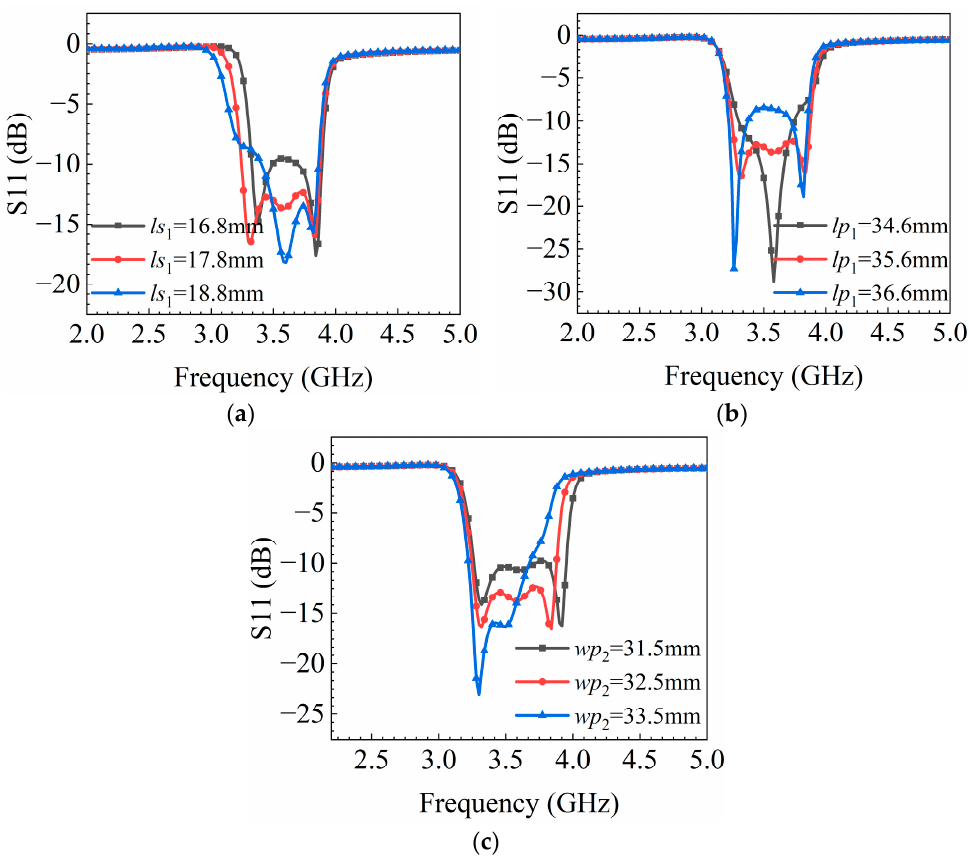
Figure 8. Simulated S11 for different parameters . ( a ) ls 1 ; ( b ) lp 1 ; ( c ) wp 2 .